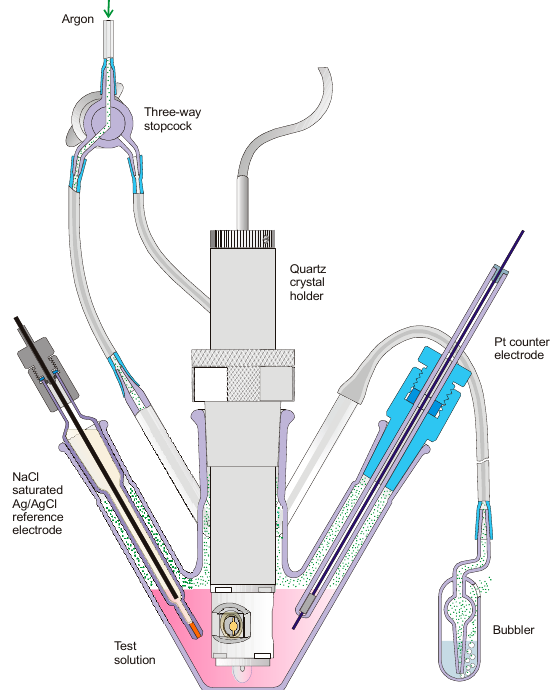
8 of 17 Figure 9. Structures of studied polymer—S XVIII Mn = 6850, D = 1.35 (* means places of chain growth). All measurements were performed on quartz microbalance type, Electrochemical Quartz Crystal Microbalance EQCM 5710 with flow-through holder 5610 (Figure 10). Analytical parameters of used QCMB are presented in Table 2. The tests were carried out in a flow cell using a constant volume of solvent. The analyte in the form of a solution in an identical solvent was injected at points marked with red arrows, and changes in the natural frequency of the disk were observed in accordance with the Sauerbrey equation. ∆𝑓 = −2𝑓 (cid:2868) (cid:2870) ∆𝑚 𝐴(𝜇 (cid:3018) 𝜌 (cid:3018) ) (cid:2869)/(cid:2870) (1) ∆ f = frequency change of a quartz resonator (MHz) ∆ m = mass change of a quartz resonator(g) μ Q = shear modulus of quartz (2.947 × 10 11 dyn ∙ cm − 2 )